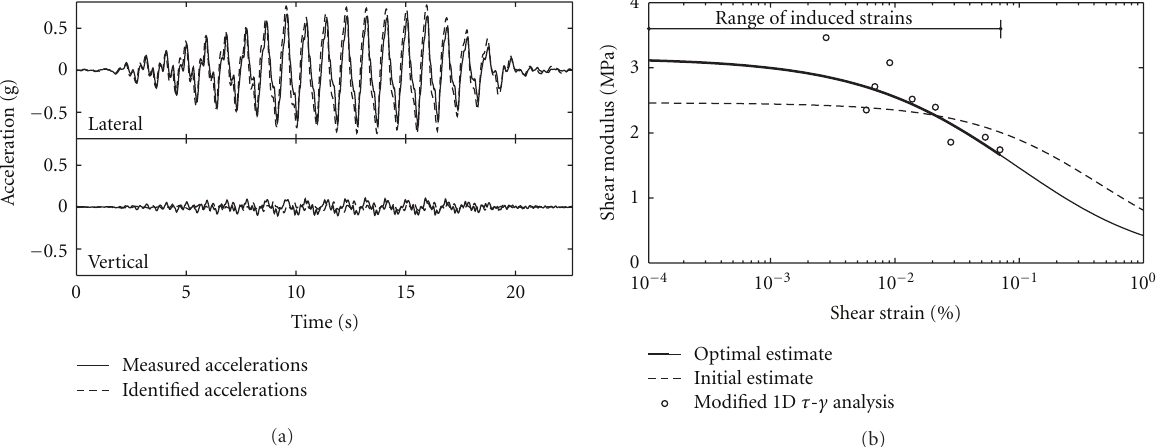
Figure 18: Local identification of the retaining wall-soil centrifuge model of Figure 17 when subjected to a strong shaking (acceleration time histories and shear moduli at the (4, 2) instrument